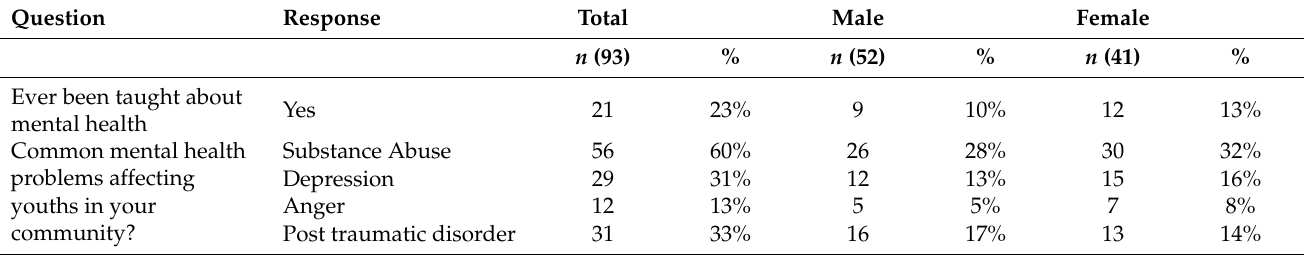
Table 3. Showing the level of mental health awareness, common mental illnesses and the available avenues for